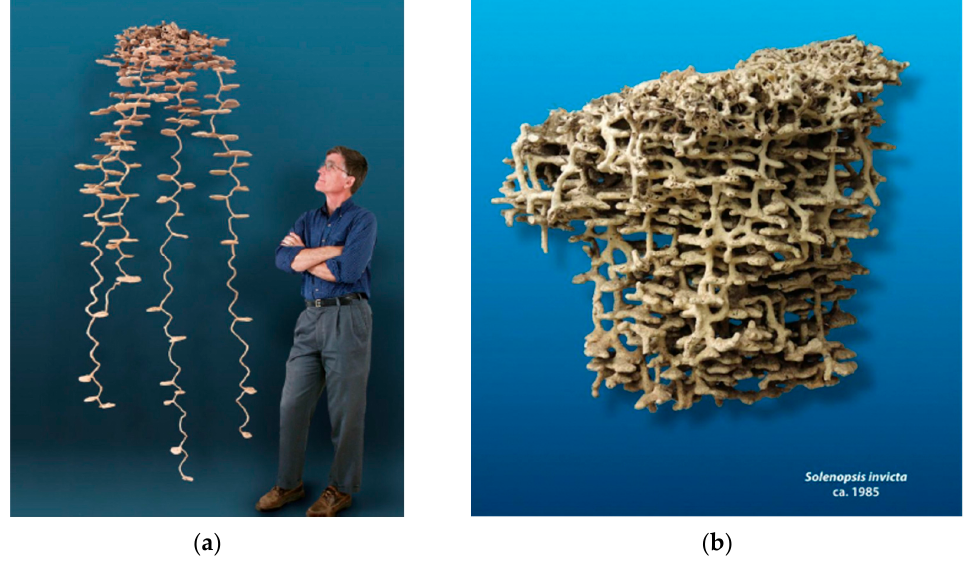
Figure 1. A plaster cast of ( a ) Pogonomyrmex badius nest and ( b ) Solenopsis invicta